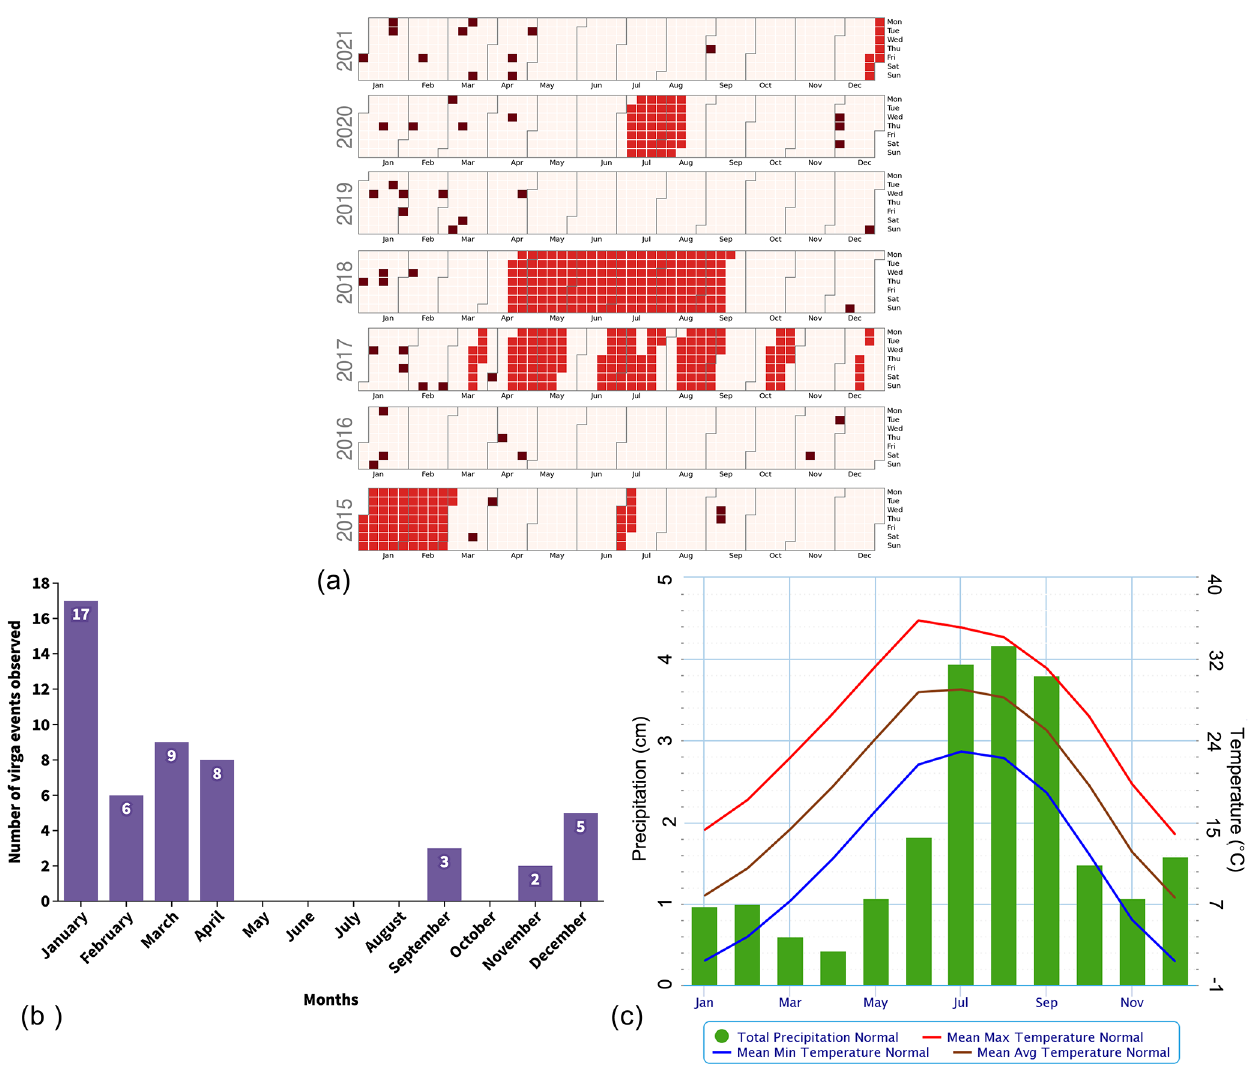
Figure 4. (a) A total of 50 virga events (burgundy) observed over the 7 years of study (2015–2021). There are days on which the instrument was not functional, and such days are marked in red. (b) Monthly distribution of the virga events during the study period. (c) Monthly climate deemed normal (1991–2020) for El Paso, Texas. Image courtesy of the National Weather Service (https://www.weather.gov/, last access: 11 October